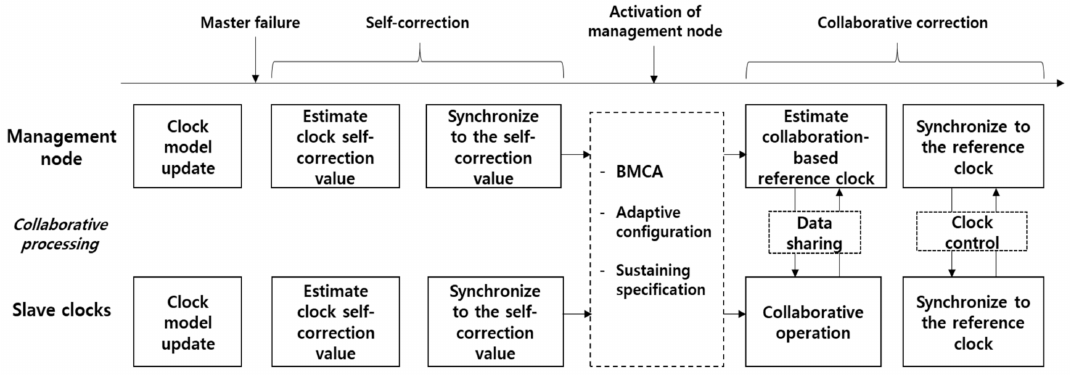
Figure 2. Operation process of the proposed